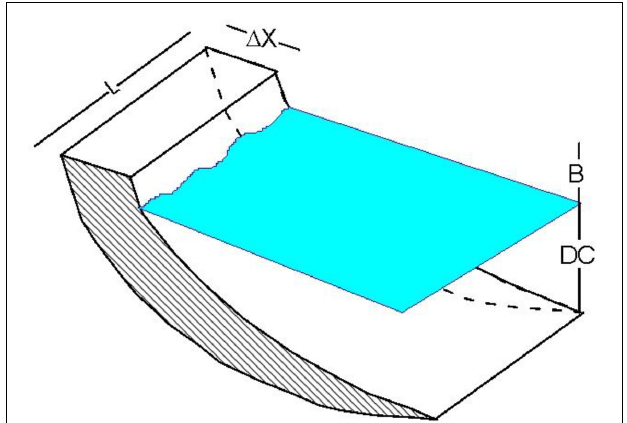
FIGURE 7 | Beach profile schematization for sediment budget calculations, indicating the berm height (B), the closure depth (DC), and characteristic distances along (L) and across ( (cid:49) x) shore to define the coastal slice